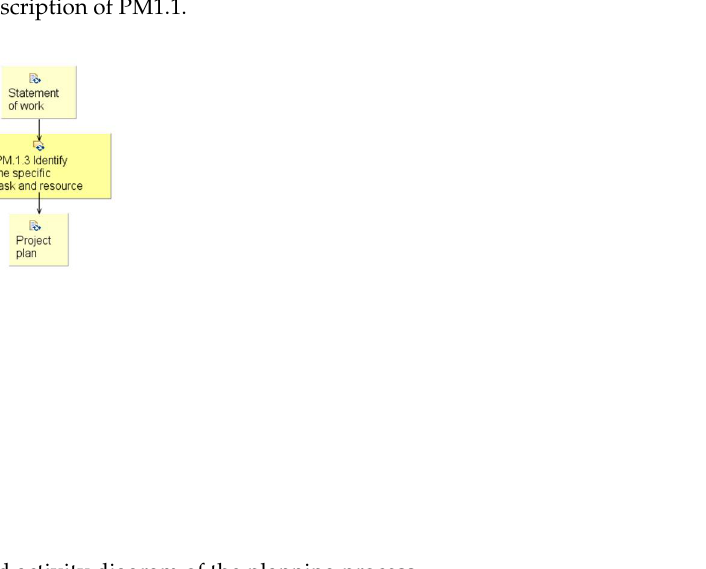
Figure 14. The task description of PM1.1.